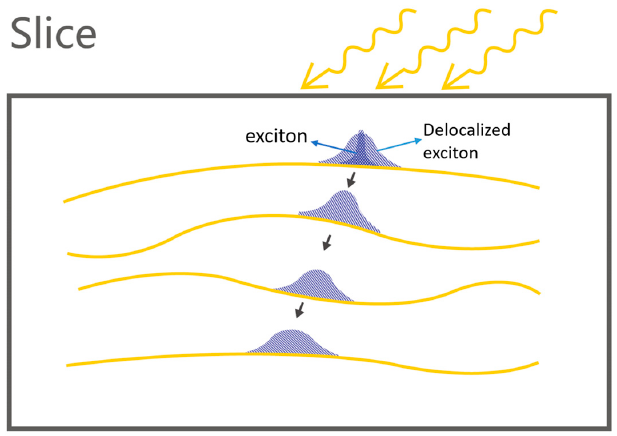
Figure 2. Hypothesis for exciton delocalization and diffusion in a bulk heterojunction solar cell.